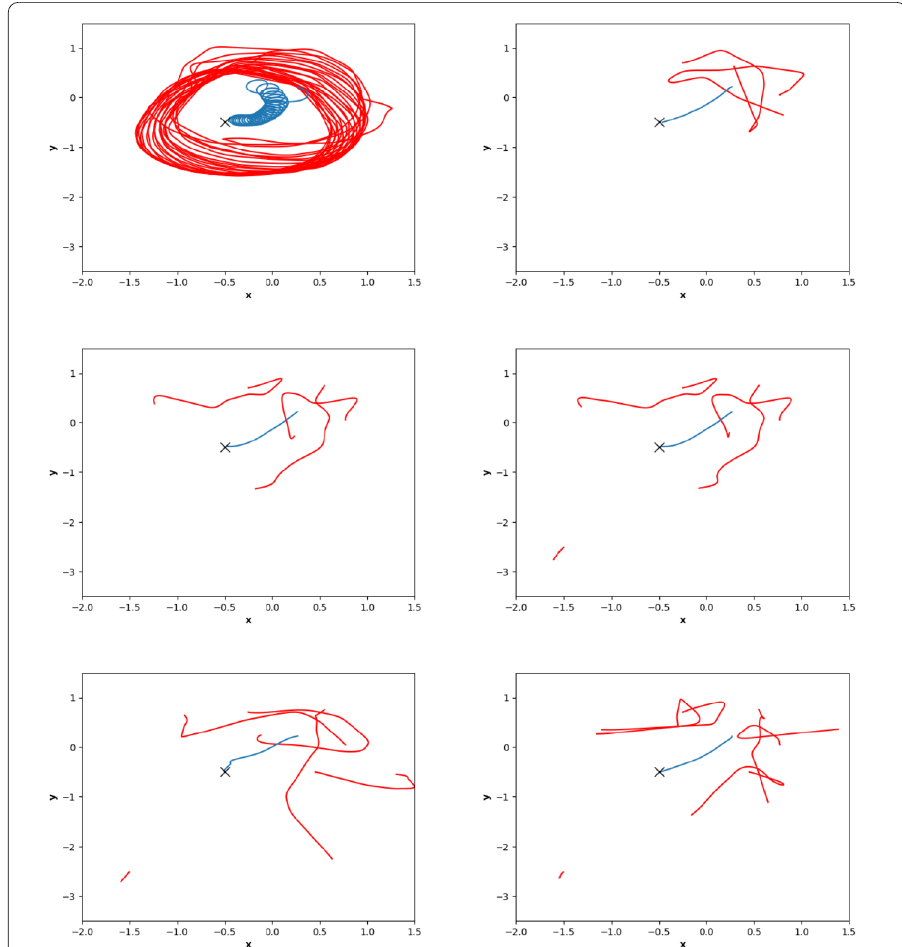
Figure 3 Space mapping trajectories for 1–6 dogs. The simulations are stopped if |¯ X – Z des | < 0.05 holds true. The corresponding times are T 1 = 3400, T 2 = 80, T 3 = 60, T 4 = 60, T 5 = 70, T 6 = 40, where the subscript refers to the number of dogs involved in the simulation. We see that already one dog is able to steer the